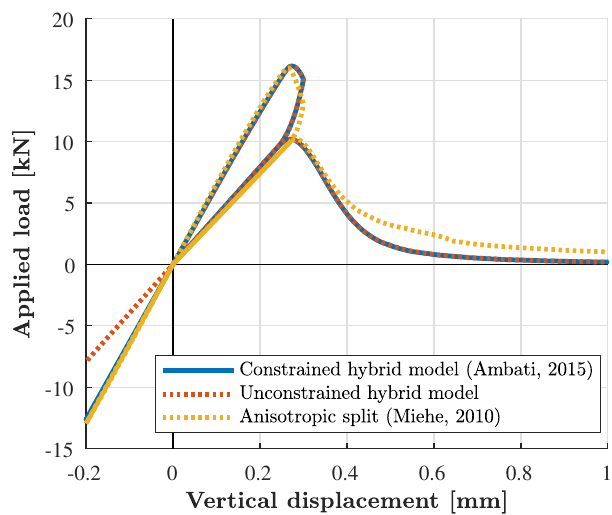
Figure 36. LSP comparison of load-displacement curves implementing the anisotropic spectral split vs. hybrid phase field models.